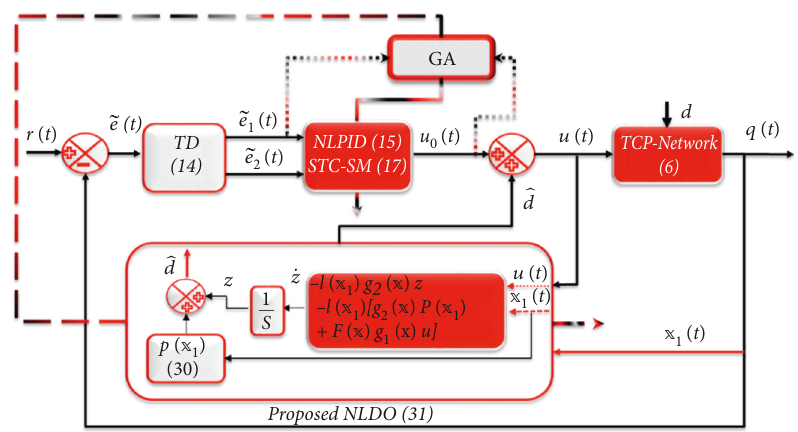
Figure 4: Completed diagram of TCP/AQM based on the proposed